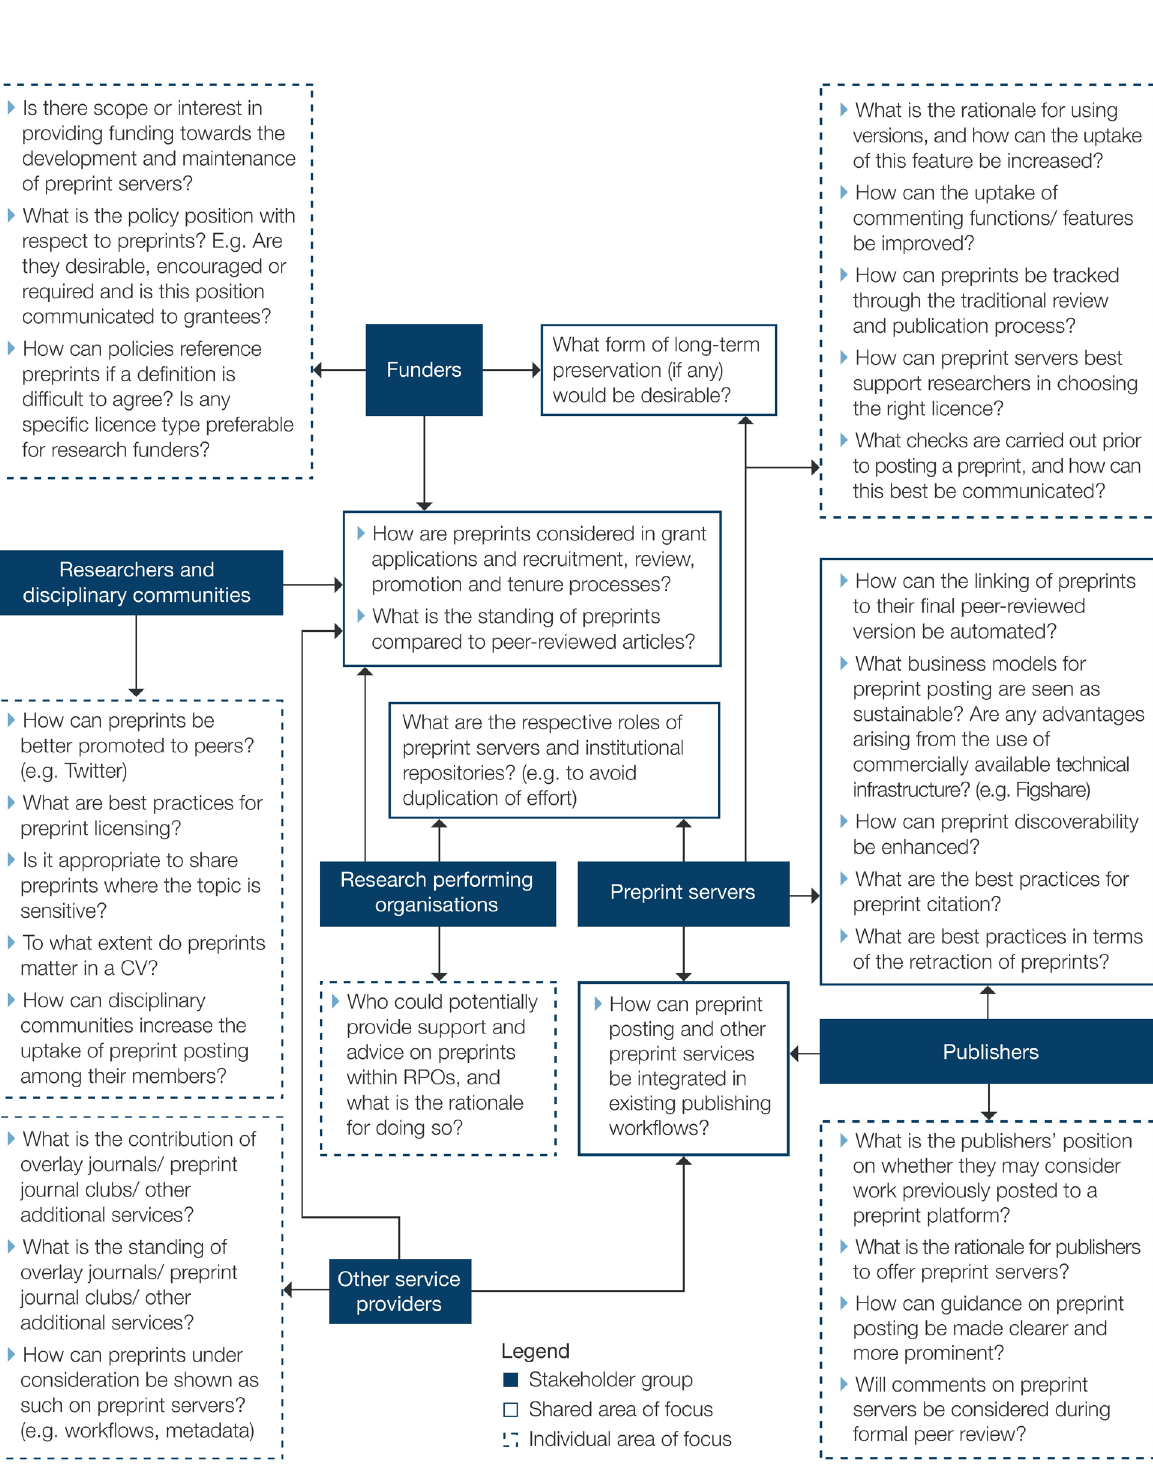
Figure 1. Questions to address in the preprints landscape (Chiarelli et al. ,